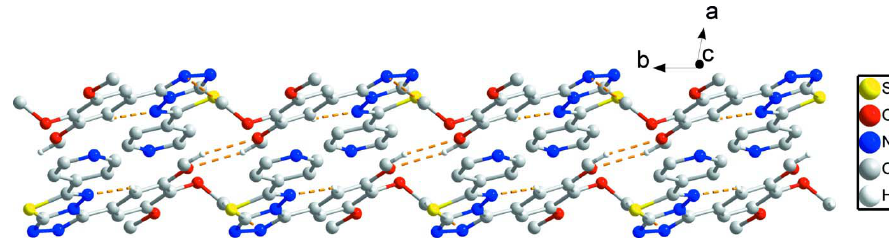
A partial packing diagram of the title compound. Hydrogen bonds are shown as dashed